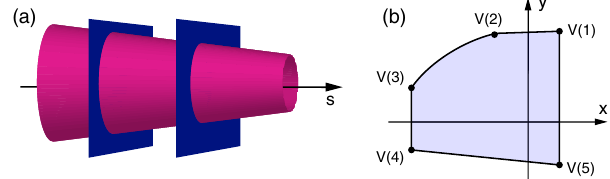
FIG. 3. A subchamber is defined by a number of cross-sectional slices. (A) A subchamber (red) and two cross-sectional slices (blue). (B) A given cross section is defined by a number of